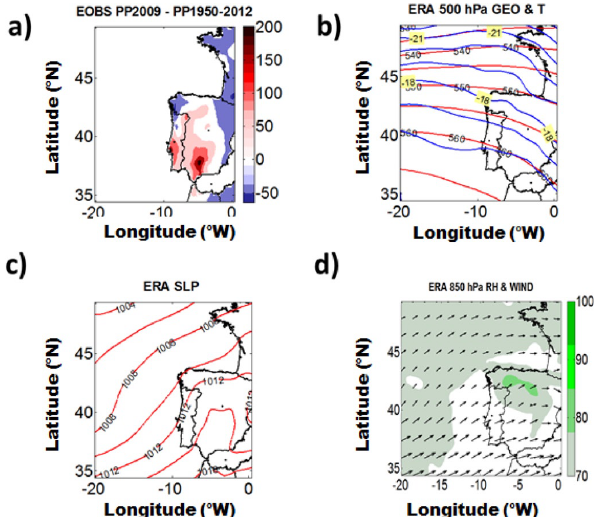
Fig. 3. (a) Precipitation difference between December 2009 and the December climatology period (1950–2012). December 2009 monthly averaged (b) 500hPa geopotential height (dam, red con- tour) and temperature (K, blue contour); (c) sea level pressure (hPa) and (d) 850hPa relative humidity (%, colour shaded) and wind vec- tor (ms − 1 ). The reanalyses are from the ERA dataset except for precipitation that are from EOBS dataset.